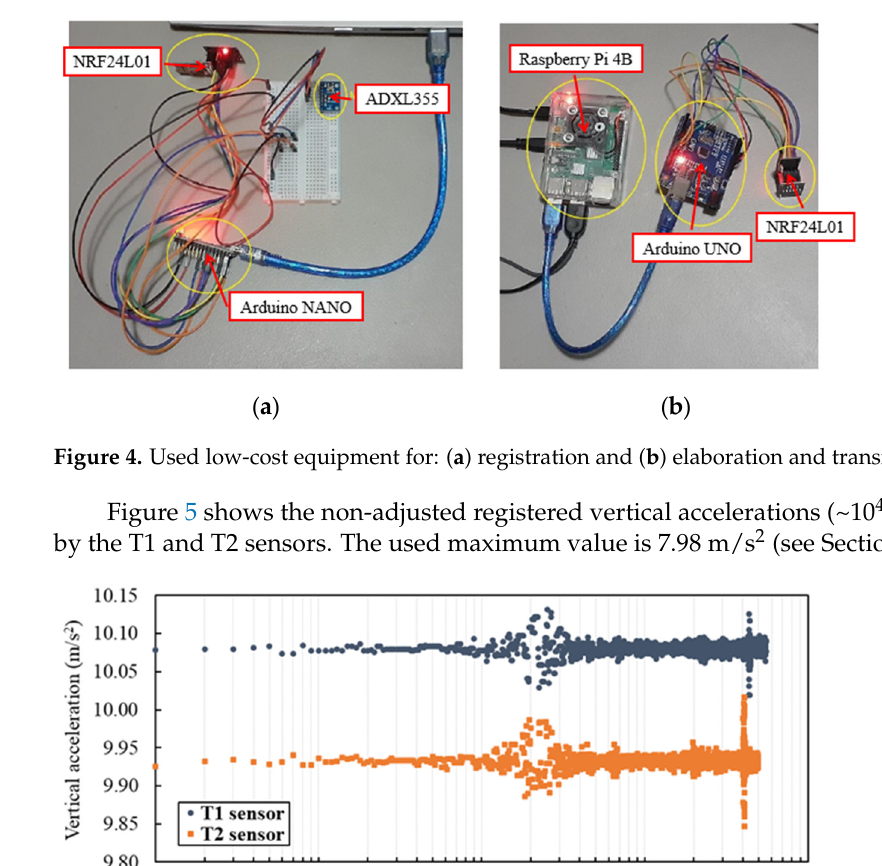
Figure 4. Used low-cost equipment for: ( a ) registration and ( b ) elaboration and transmission of data. For the elaboration and transmission of data, the same accelerometer and “NRF24L01” device were used with the “Arduino NANO” device for the transmission, and the micro-computer “Raspberry Pi 4B” (see point A in Figure 1a) and microcontrollers “Arduino UNO” (Figure 4b) device for the elaboration/visualisation.